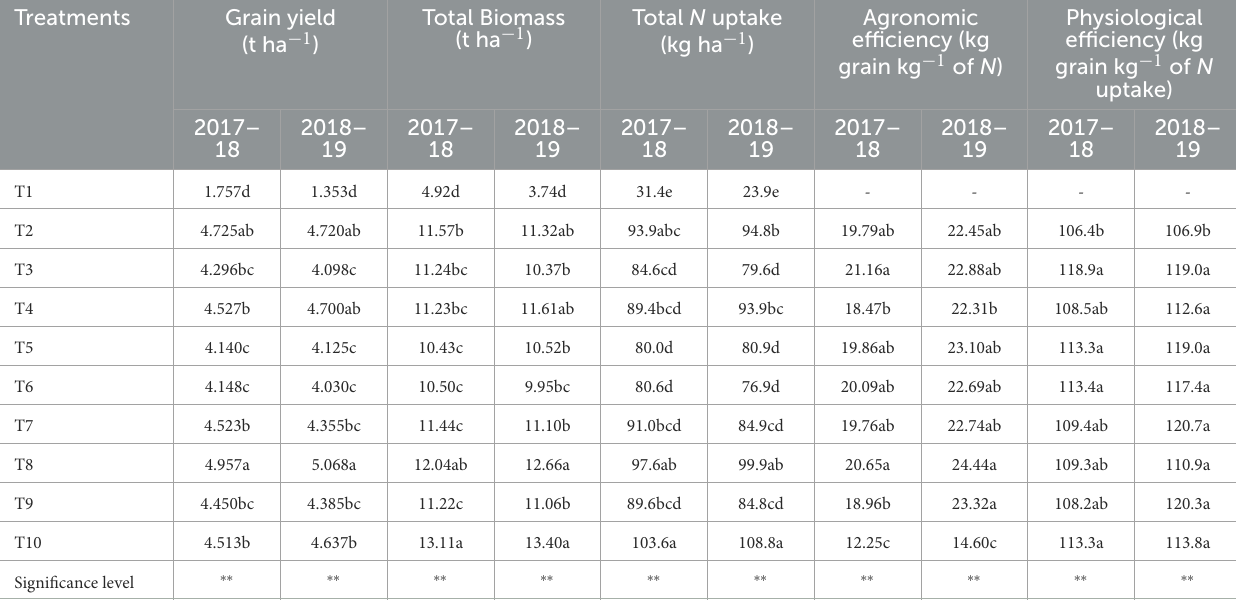
TABLE 4 Grain yield, total biomass production, and NUE of wheat as influenced by various nitrogen scheduling. Treatments